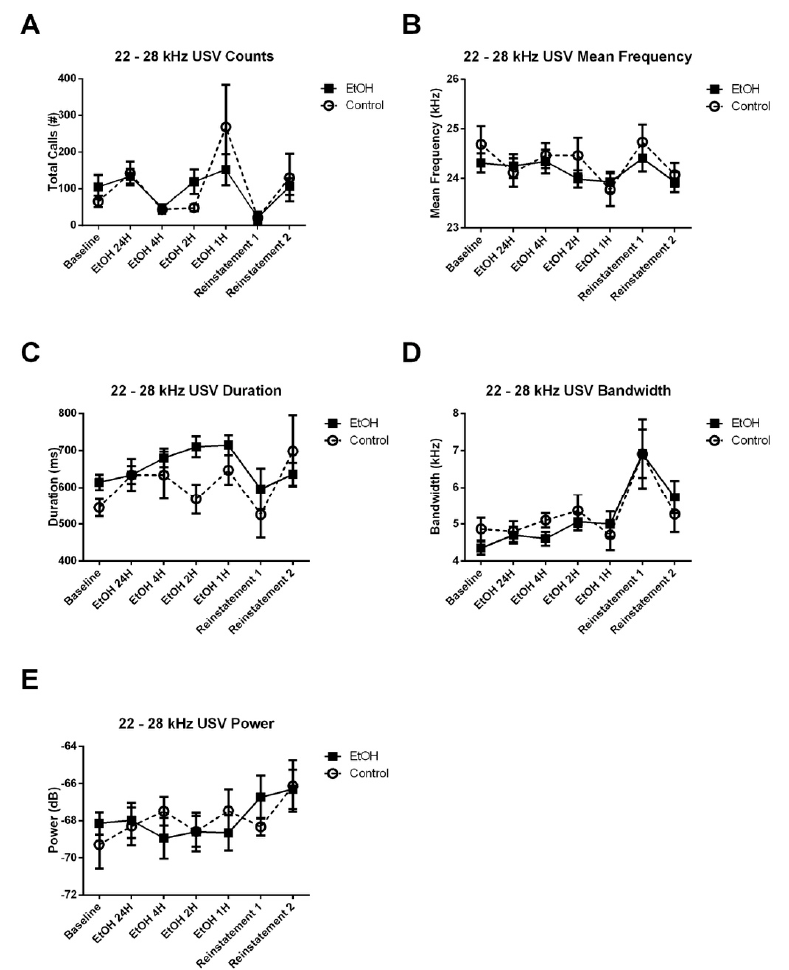
Figure 7. Effect of EtOH exposure on counts and acoustic characteristics of 22–28 kHz USVs emitted during the 4-h session. ( A ) There was no Treatment × Experiment Stage interaction, nor any main e ff ect of treatment on the number of 22–28 kHz calls. ( B ) There was a significant Treatment × Experiment Stage interaction for mean frequency ( p < 0.0001), ( C ) duration ( p < 0.0001), ( D ) bandwidth ( p < 0.001), and ( E ) power ( p < 0.0001) of these calls.